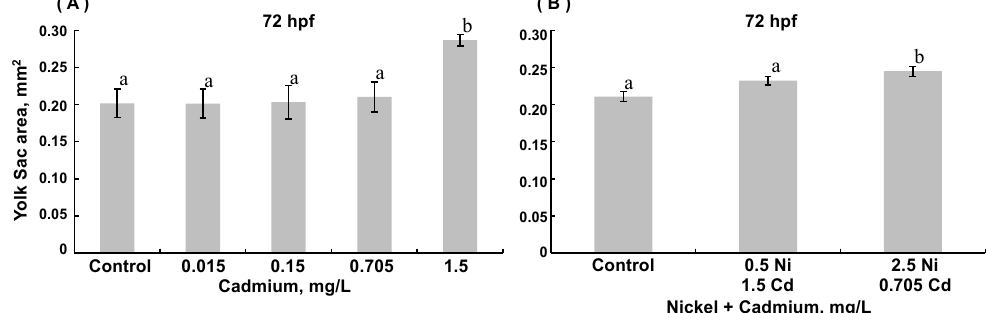
Figure 6. Yolk sac area in 72 hpf zebrafish embryos reared in medium containing ( A ) 0.15–1.5 mg/L Cd and ( B ) combinations of either 0.5 mg/L Ni + 0.15 mg/L Cd or 2.5 mg/L Ni + 0.705 mg/L Cd. ( A ): 72 hpf with Cd exposure, ANOVA p < 0.0001. ( B ): 72 hpf with combined metal exposure, ANOVA p < 0.0001. (Data are means ± SEM for N = 50–80 surviving embryos.).